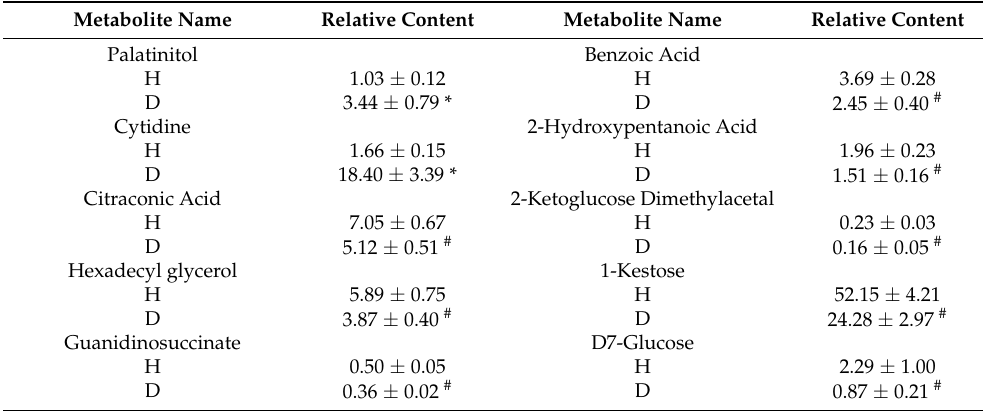
Figure 6. Thermogram analysis of different metabolites in bayberry rhizosphere soil. H and D represent healthy and diseased trees, respectively. The color scale is representative of the relative content of metabolites, where a high relative content is indicated in red and a low relative expression is indicated in green. Table 4. The relative contents of the differential metabolites in rhizosphere soil between healthy and decline disease trees.